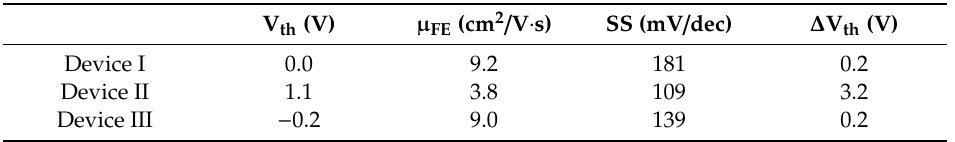
Figure 2. ( a ) Transfer curves of the TFTs I, II and III (W / L = 100 / 10 µ m) before bias stress. The transfer curves were measured before and after 1 h of PBTS (dash line) at V DS = 0.1 and 10 V for ( b ) device I, ( c ) device II and ( d ) device III, respectively. Table 1. Summary of the device parameters and bias stability for the three TFTs. The threshold voltage shift ( ∆ V th ) was measured after 1 h PBTS.